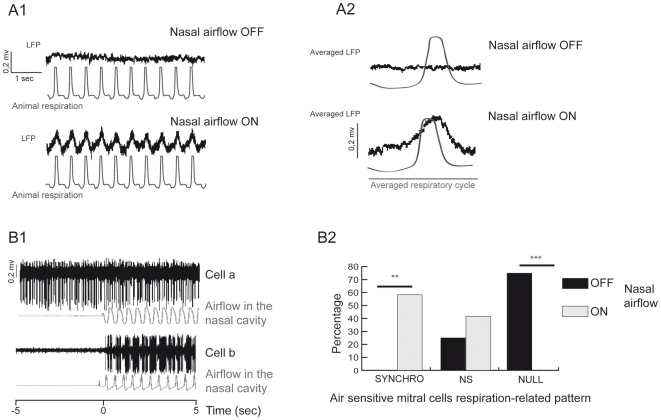
Nasal airflow (without any odor) imposes a respiration-related rhythm.A1) Dark traces: examples of field potentials recorded in the mitral cell layer when airflow was OFF (top) and ON (bottom). Gray traces: animal respiratory signal measured at the tracheal cannula. A2) Field potentials averaged over the respiratory cycle when airflow was OFF (top) and ON (bottom). B1) Forty five mitral cells were recorded under nasal airflow ON and OFF conditions. Raw data filtered at 300–3000 Hz of: an air-insensitive cell (a) and an air-sensitive cell (b). Bottom trace: airflow in the nasal cavity (500 ml/min) recorded at the nostril entrance. Nasal airflow was simulated at time 0. B2) Percentages of respiration-related (SYNCHRO), respiration non-related (NS) and null activity (NULL) patterns in air-sensitive cells when airflow was OFF (black) and ON (gray) in the nasal cavity (n = 12). Of these 12 cells, seven shifted from the NULL to SYNCHRO pattern, two from the NULL to NS and three from NS to NS (with a change in spike rate). Statistical test: Chi2, **p < 0.01, ***p<0.001.